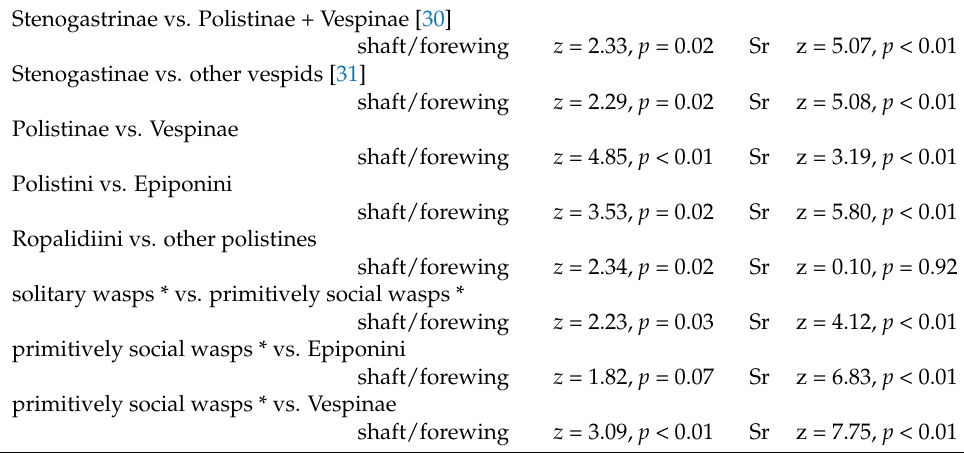
Table 2. Tests (Mann–Whitney U) of difference in means of two key ratios in selected monophyletic groups and paraphyletic groups representing social grades in vespid wasps—based on the same data-set as Table 1. The first ratio under each pair is the relative lengths of the sting shaft and forewing, while the second is the relative serration index. Paraphyletic groups are marked with asterisks. In each comparison, z is the test